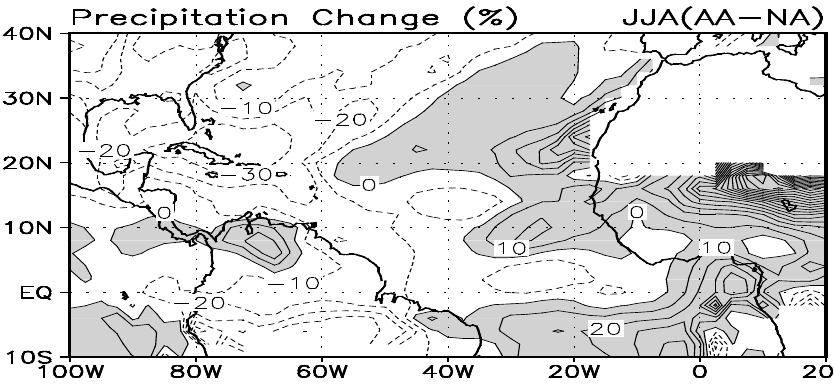
Figure A1 Spatial pattern of percentage change of rainfall anomaly (AA-minus-NA), induced by the EHP mechanism.